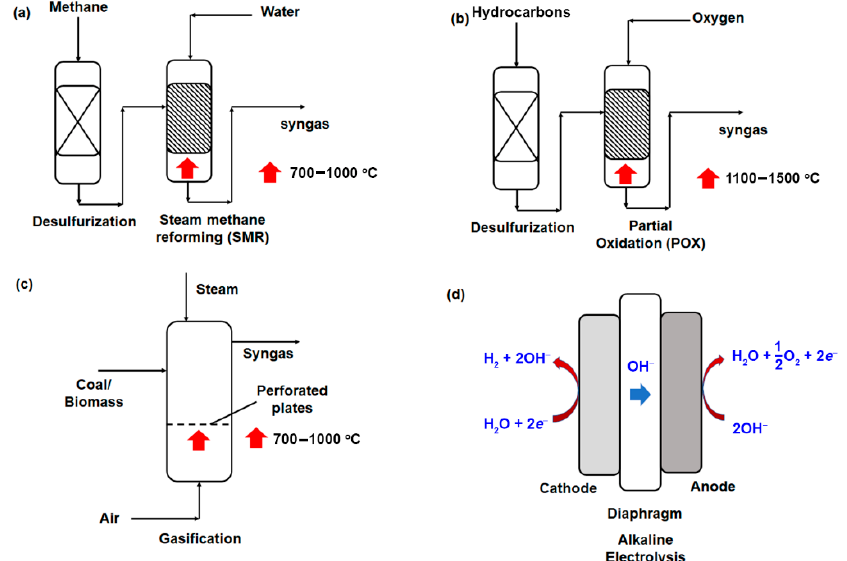
Figure 1. Methods to generate hydrogen gas from the feed ( a ) steam methane reforming (SMR), ( b ) partial oxidation (POX), ( c ) gasification, and ( d ) alkaline electrolysis. Reprinted with permission from Ref. [25] , Creative Commons license CC BY 4.0.